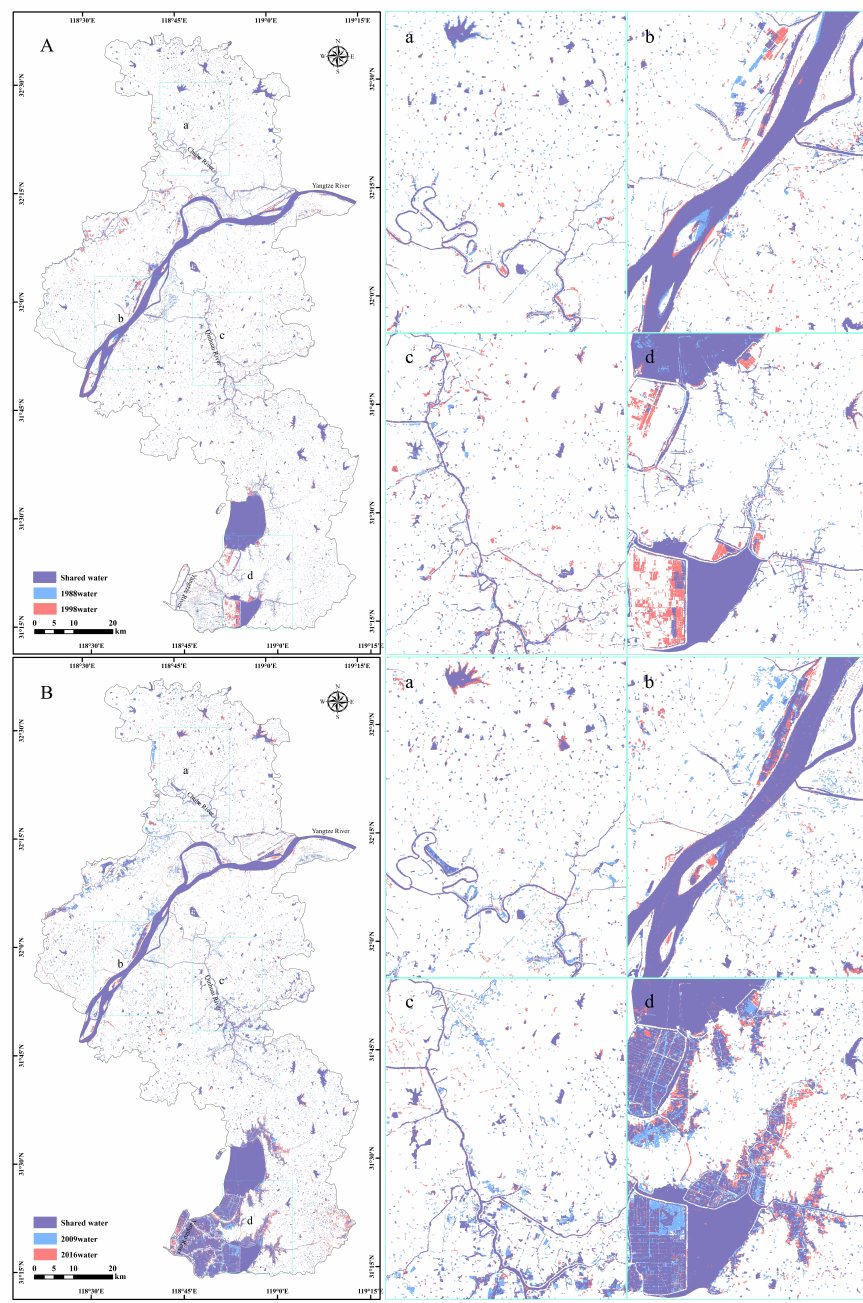
Figure 6. Spatial distribution and variation of surface water in the periods 1987–1989 ( A ), 1997–1999 ( A ), 2008–2010 ( B ), and 2015–2017 ( B ); a, b, c, and d show the enlarged areas in the Chuhe River system (ChRS), the Yangtze River Nanjing section (YRNS), the Qinhuai River system (QhRS), and the Shuiyang River system (SyRS),